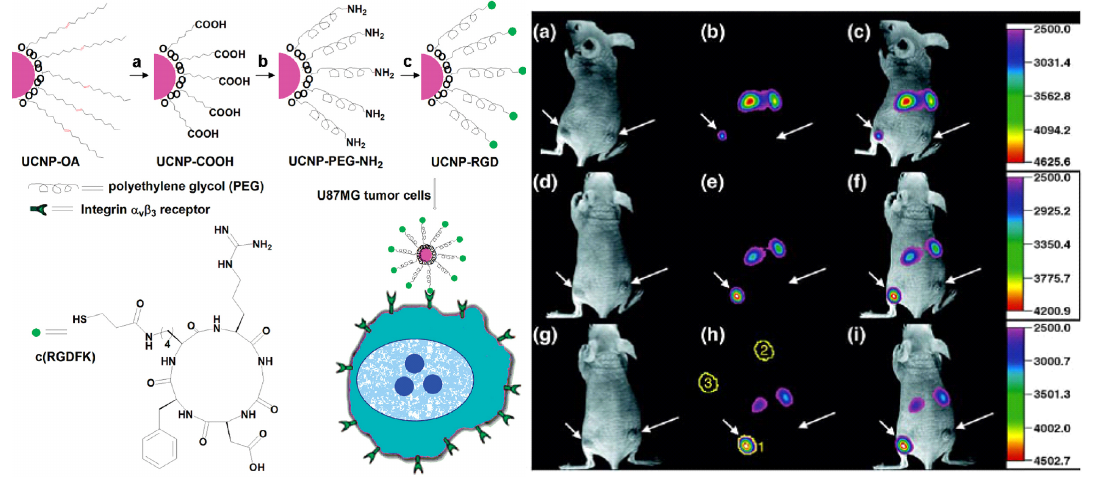
Figure 11. Illustration scheme for UCNP-RGD and in vivo upconversion luminescence imaging of subcutaneous U87MG tumor (left hind leg) and MCF-7 tumor (right hind leg) after intravenous injection of UCNP-RGD conjugate over 24-hour period. ( a , d , g ) bright field, ( b , e , h ) upconversion images, ( c , f , i ) overlay of the corresponding bright field images with the upconversion ones. ( a – c ), ( d – f ), and ( g – i ) are taken at 1, 4 and 24 h postinjection, respectively. Reprinted with permission from [35]. Copyright American Chemical Society,